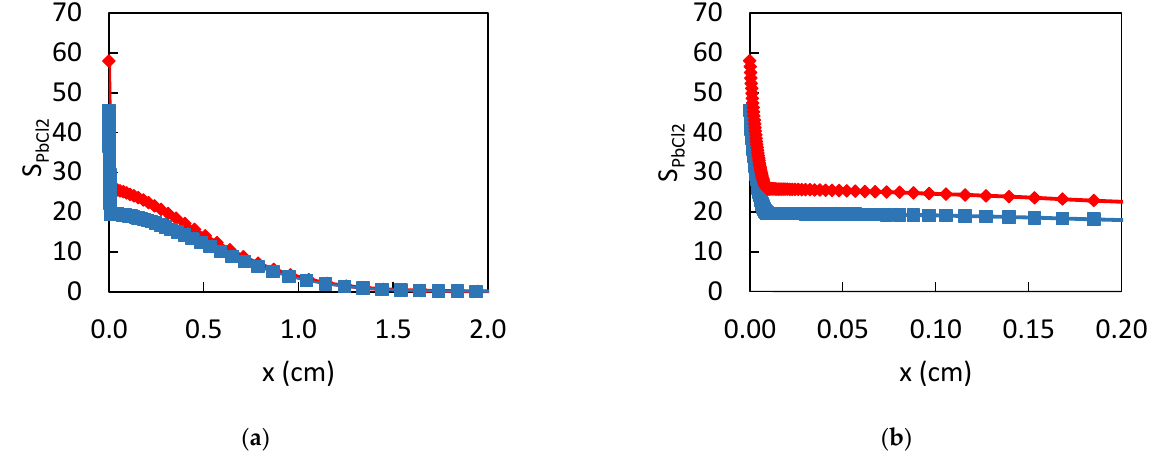
Figure 16. Evolution of S PbCl2 ( a ) on the first 2 cm and ( b ) on the first 200 µm of the electrolyte, for (blue) the fixed porosity case and (red) the variable porosity case.